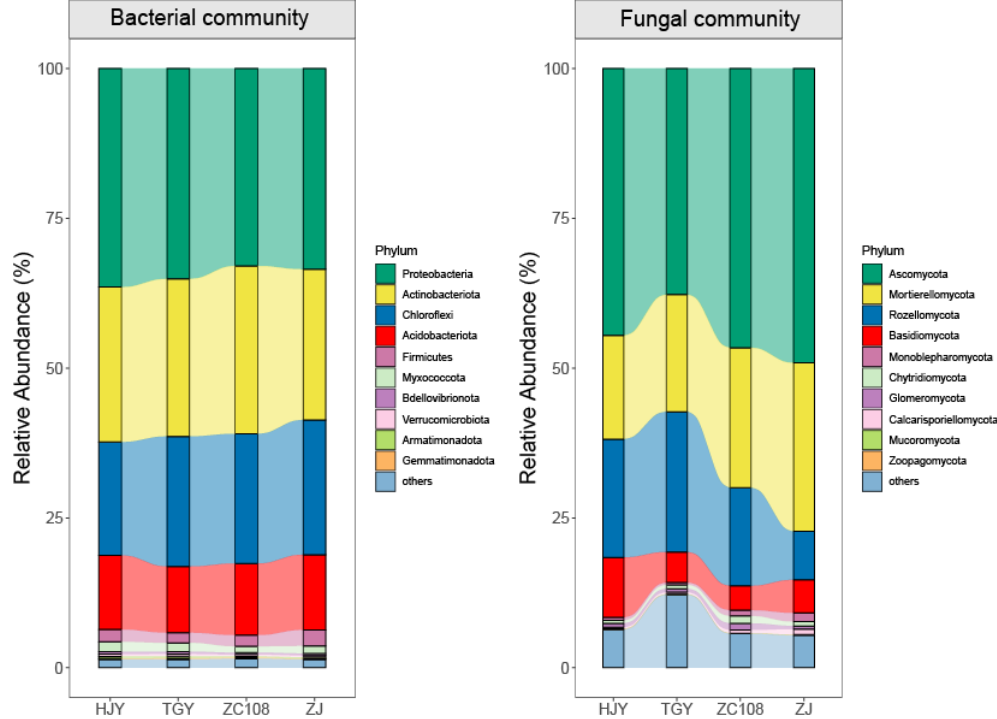
Figure 4. The relative abundance of the top 10 bacterial ( left panel) and fungal ( right panel) taxa at the phylum levels in the tea plantation soils under four tea plant cultivars. HJY, Huangjinya, TGY, Tieguanyin, ZC108, Zhongcha108, ZJ,